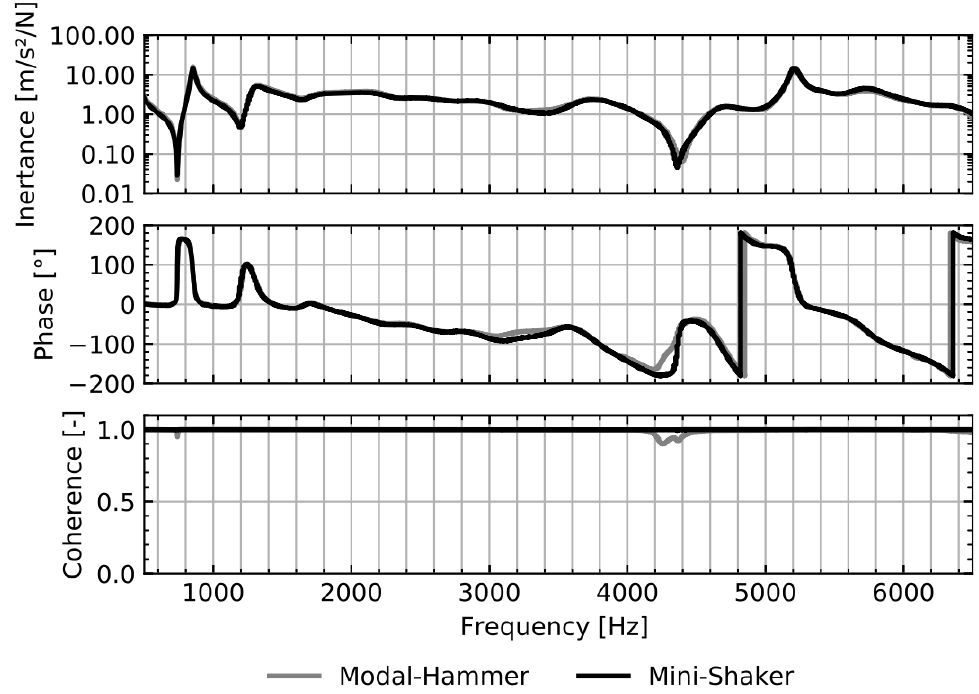
Figure 4. Inertance, phase, and coherence of the hammer and shaker excitation at 0° position in radial reaction direction.